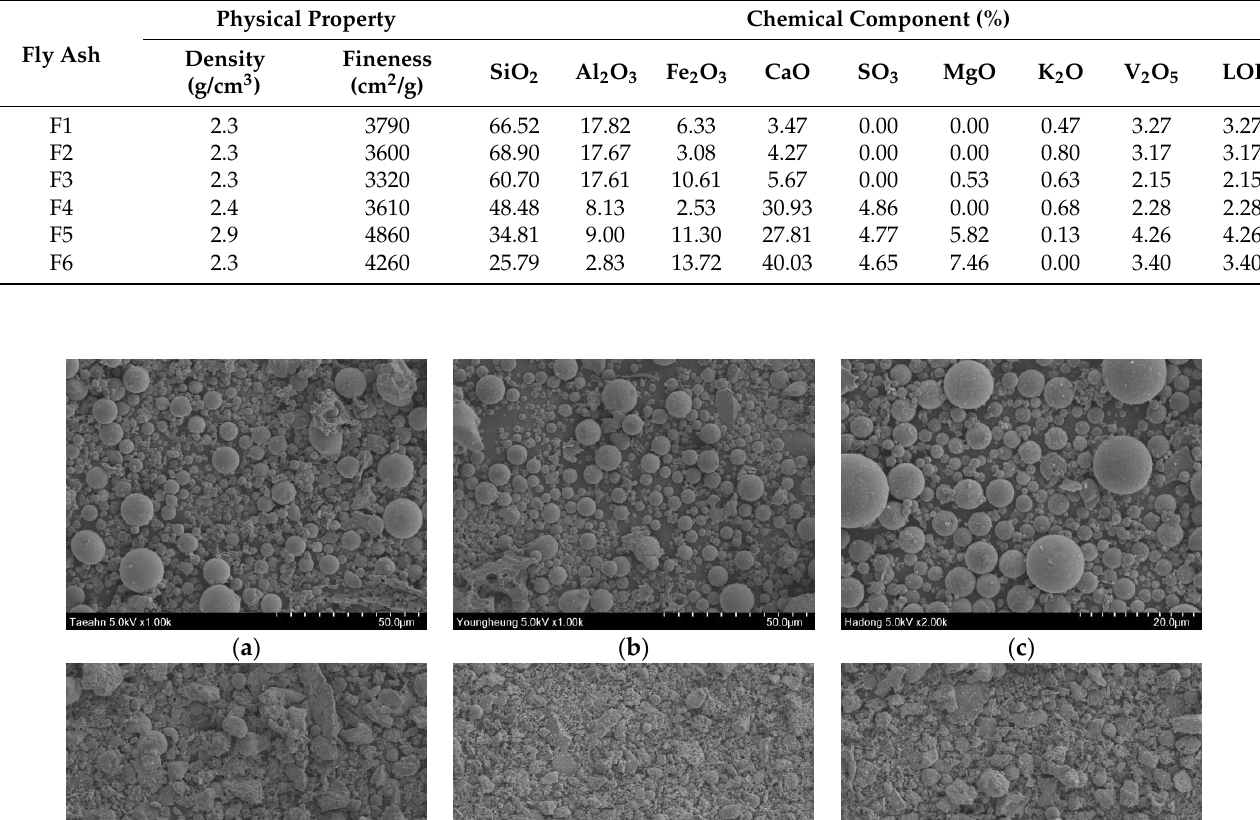
Table 2. Mix design for CLSM used in this study.